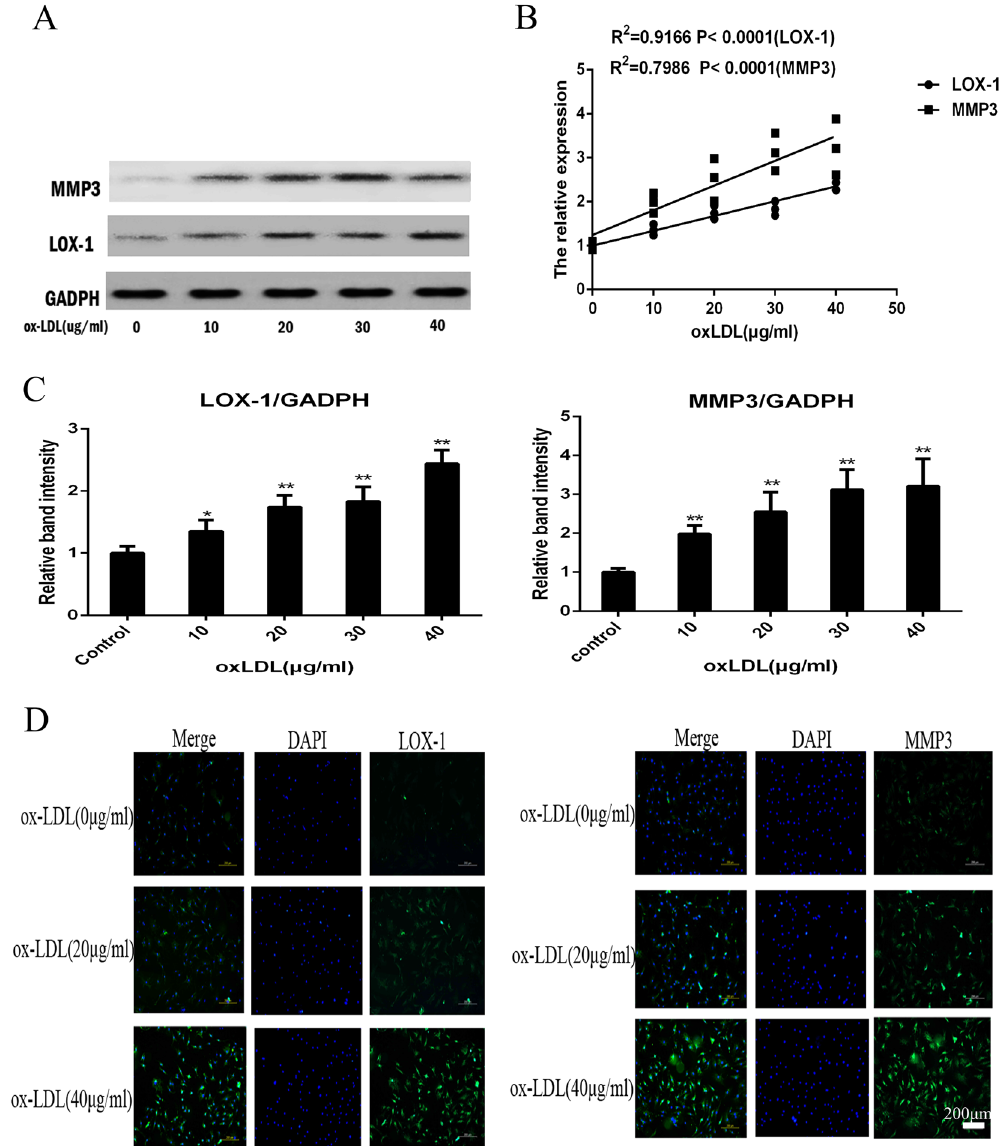
Figure 4. OxLDL can increase the expression of LOX-1 and MMP3. ( A , C ) Western blotting analysis for the protein expressions of LOX-1 and MMP3. Nucleus pulposus cells were treated with 48 h for different concentration periods (0–40 μ g/ml). The LOX-1 and MMP3 was quantified. Data were presented as mean ± SD from three independent experiments. The cells without oxLDL treatment were served as control. ( B ) The Correlations analysis between LOX-1 and intervertebral disc degeneration score were performed (R 2 LOX-1 = 0.92, P < 0.0001; R 2 MMP3 = 0.80, P < 0.0001). Data are presented as means ± SD. ( D ) Representative fluorescent microscopic images of Hoechst/PI double stained nucleus pulposus cells showing that the increasing concentration of oxLDL (only show 0 μ g/ml, 20 μ g/ml and 40 μ g/ml) can promote the expression of LOX-1 and MMP3. Bars = 200 μ m. ( * P < 0.05, ** P <